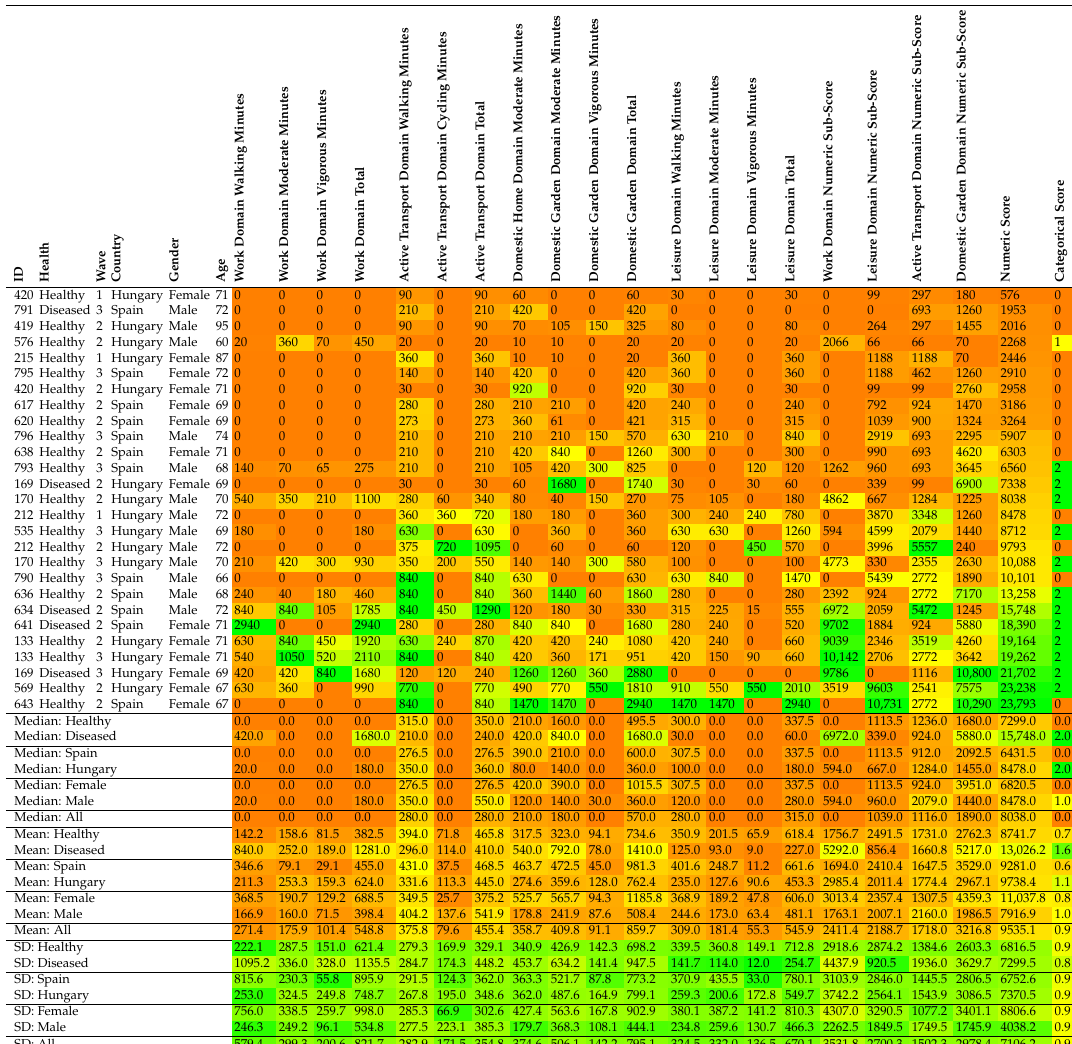
Table A3. Characteristics of PRO Physical Activity (IPAQ).